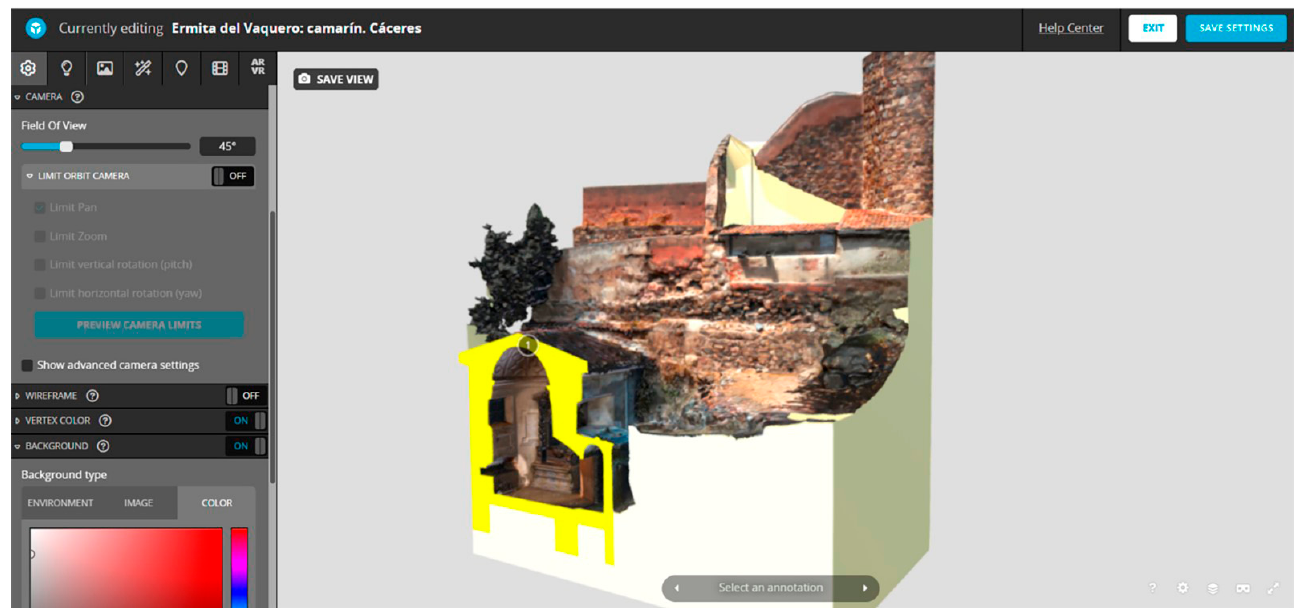
Figure 14. Sketchfab interface. Setting up the scene.